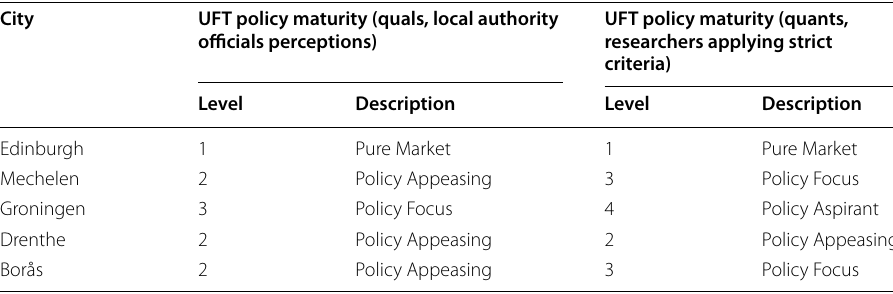
Table 2 Case study cities level of UFT policy maturity City UFT policy maturity (quals, local authority officials